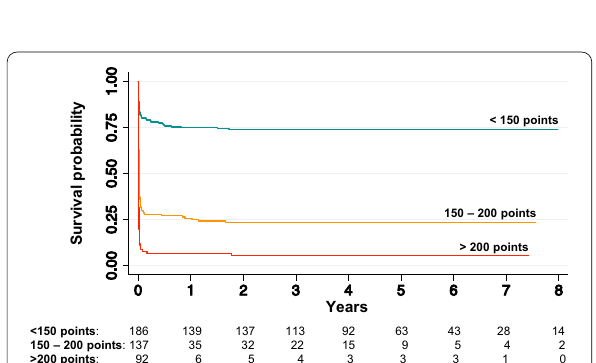
Fig. 2 Kaplan–Meier survival estimates with number at risk for predefined CAHP score categories. Below the x -axis, number at risk for the individual time points are